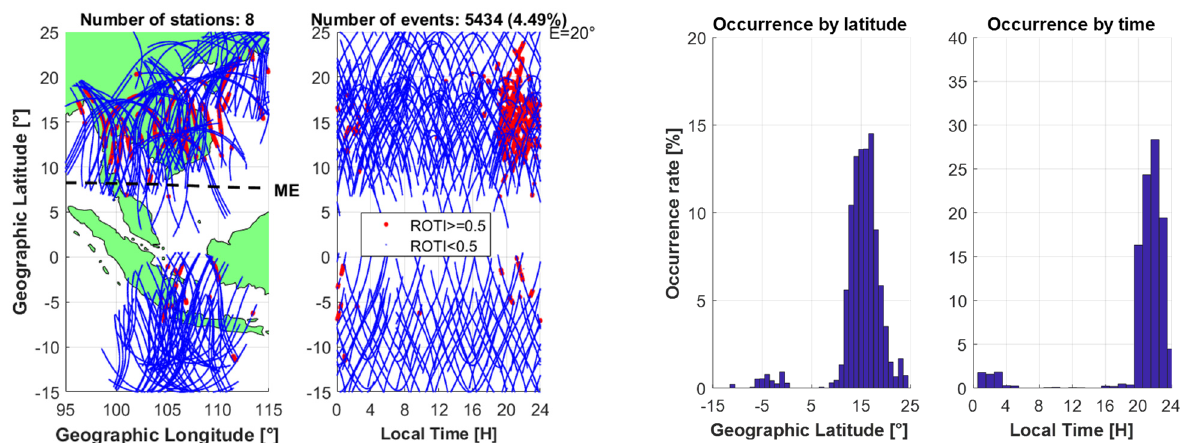
Figure 10. Regional ROTI maps and the occurrence rates of ionospheric scintillations in Southeast Asia on 19, 20, 26, and 31 October in 2015, listed in order from top to bottom:. In these figures, plots on the left side are the regional ROTI maps, while plots on the right side show the percentages of the occurrence of ionospheric irregularities both in terms of latitude and time. ME stands for the magnetic equator. The dots in the ROTI maps represent satellite footprints tracking the intersections between the line of sight (LOS) from satellites to receivers and the singer layer model (SLM) of the ionosphere at an altitude of 450 km. The red dots indicate observations with ROTI of no less than 0.5 TECU/min, which is the sign of ionospheric disturbances, while the blue ones show the quiet status of the ionosphere (ROTI < 0.5 TECU/min). Data for these maps are the GNSS measurements from all available IGS stations in the research area (usually 8 stations). The total number of ionospheric irregularities detected and the percentage of all observed measurements are also given in the top of the ROTI maps and are listed in columns 10 and 11 of Table 3. Meanwhile, the plots of ionospheric scintillation occurrences on the right side show the appearance percentages in terms of latitude (resolution of 1°) and time (resolution of one hour), which are the percentages of all detected ionospheric irregularities, not of all observed measurements.